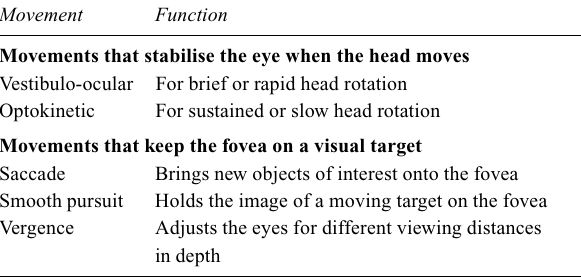
Table 1 A functional classification of eye movements Movement Function